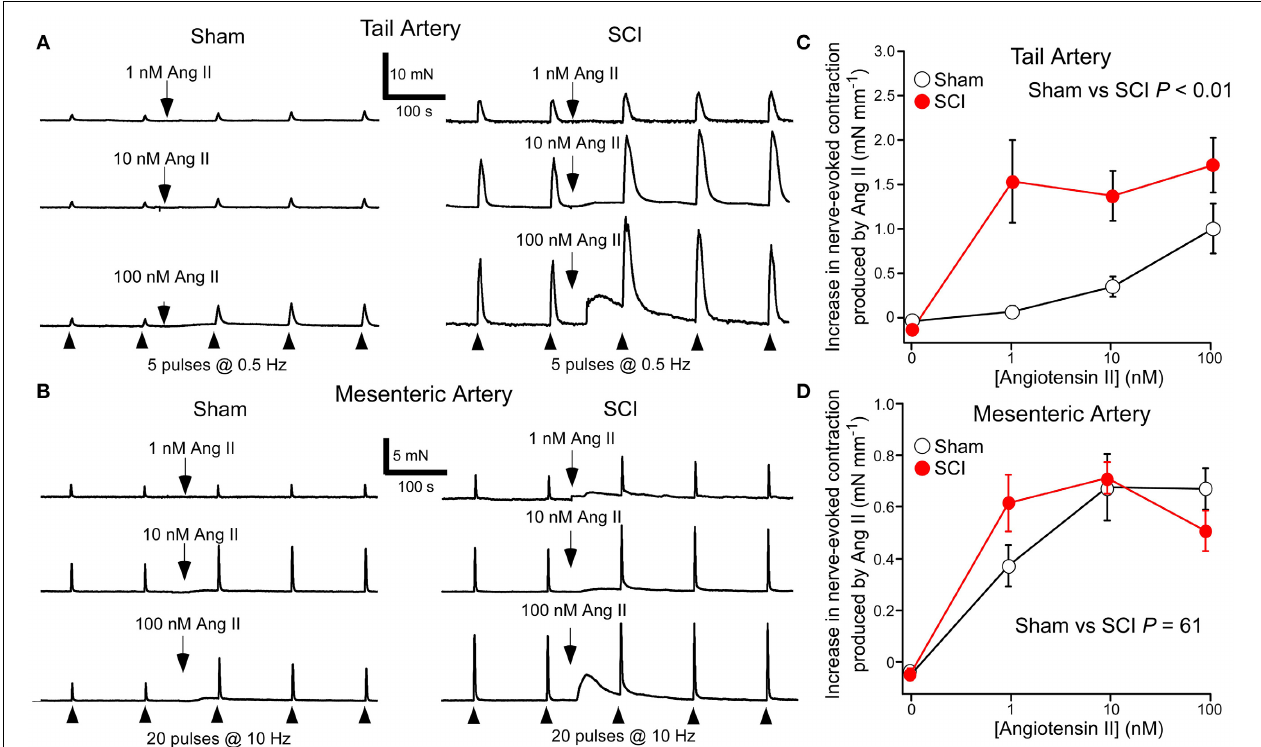
FIGURE 3 | Angiotensin II (Ang II) increased nerve-evoked contractions of both tail arteries and mesenteric arteries. In tail arteries, but not mesenteric arteries, the increment in the size of nerve-evoked contractions produced by Ang II was markedly increased by spinal cord injury (SCI). (A) Representative traces showing contractions of tail artery segments from a sham-operated ( left panel ) and a SCI ( right panel ) rat evoked by 5 stimuli at 0.5Hz before and during application of 1, 10, and 100nM Ang II. (B) Representative traces showing contractions of mesenteric artery segments from a sham-operated ( left panel ) and a SCI ( right panel ) rat evoked by 20